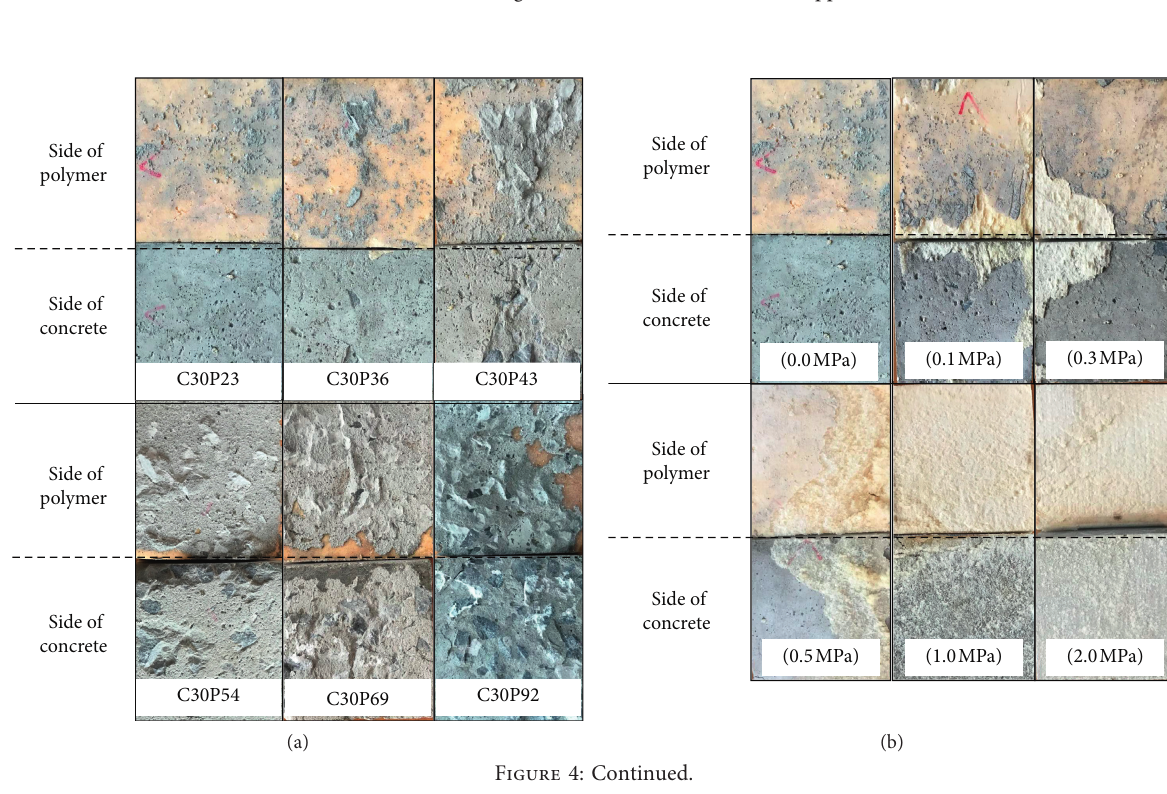
Figure 3: Schematic diagrams of modified direct shear